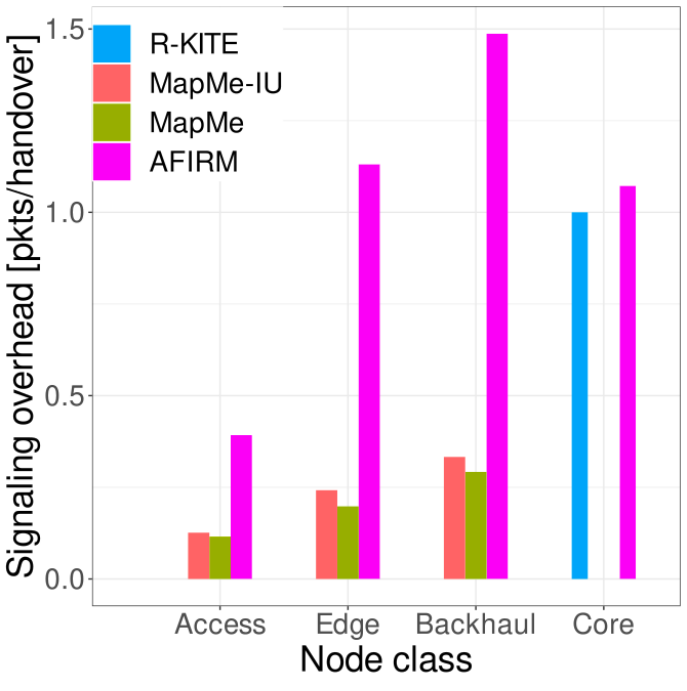
Figure 10. Signaling